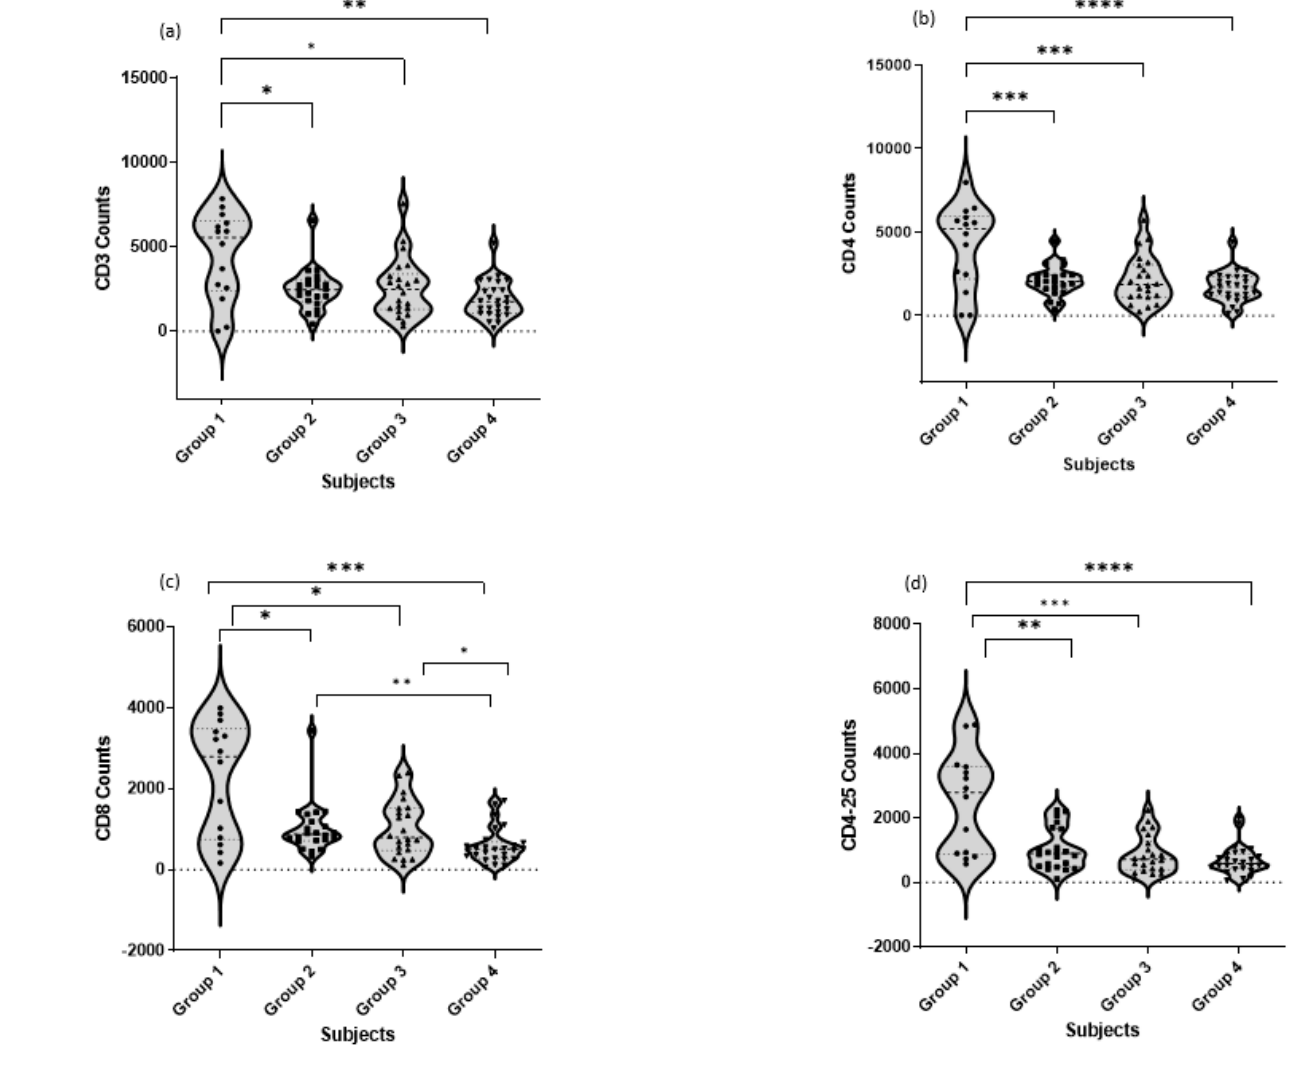
Figure 2. Comparison of cell counts of total CD3 + T cells (Mann–Whitney) and different sub types: Th CD4 + ( t -test), Tc CD8 + cells (Mann–Whitney), and Treg CD4 + CD25 + cells (Mann–Whitney) in different COVID-19 patients. Data represent the cell count of ( a ) CD3 + , ( b ) CD4 + , ( c ) CD8 + , and ( d ) CD4 + CD25 + T cells in mild/asymptomatic, moderate, and severe/critical COVID-19 patients. For all analyzed T cell subtypes, a significant difference was recorded between healthy control and COVID-19 groups of patients. * p -value < 0.05 is considered significant, ** p -value < 0.01 is considered very significant, *** p -value < 0.001 and **** p -value < 0.0001 are considered extremely significant. Table 4. Comparison of the percentage of total CD3 + T cells and different T cell subtypes, Th CD4 + , Tc CD8 + , and Treg CD4 + CD25 + , between different COVID-19 patient groups and controls. Mild/Asymptomatic Severe/Critical T Cell Subtypes Controls Moderate Cases Cases Cases CD3 Cells % 41.15 ±4.823 Mean ± SD